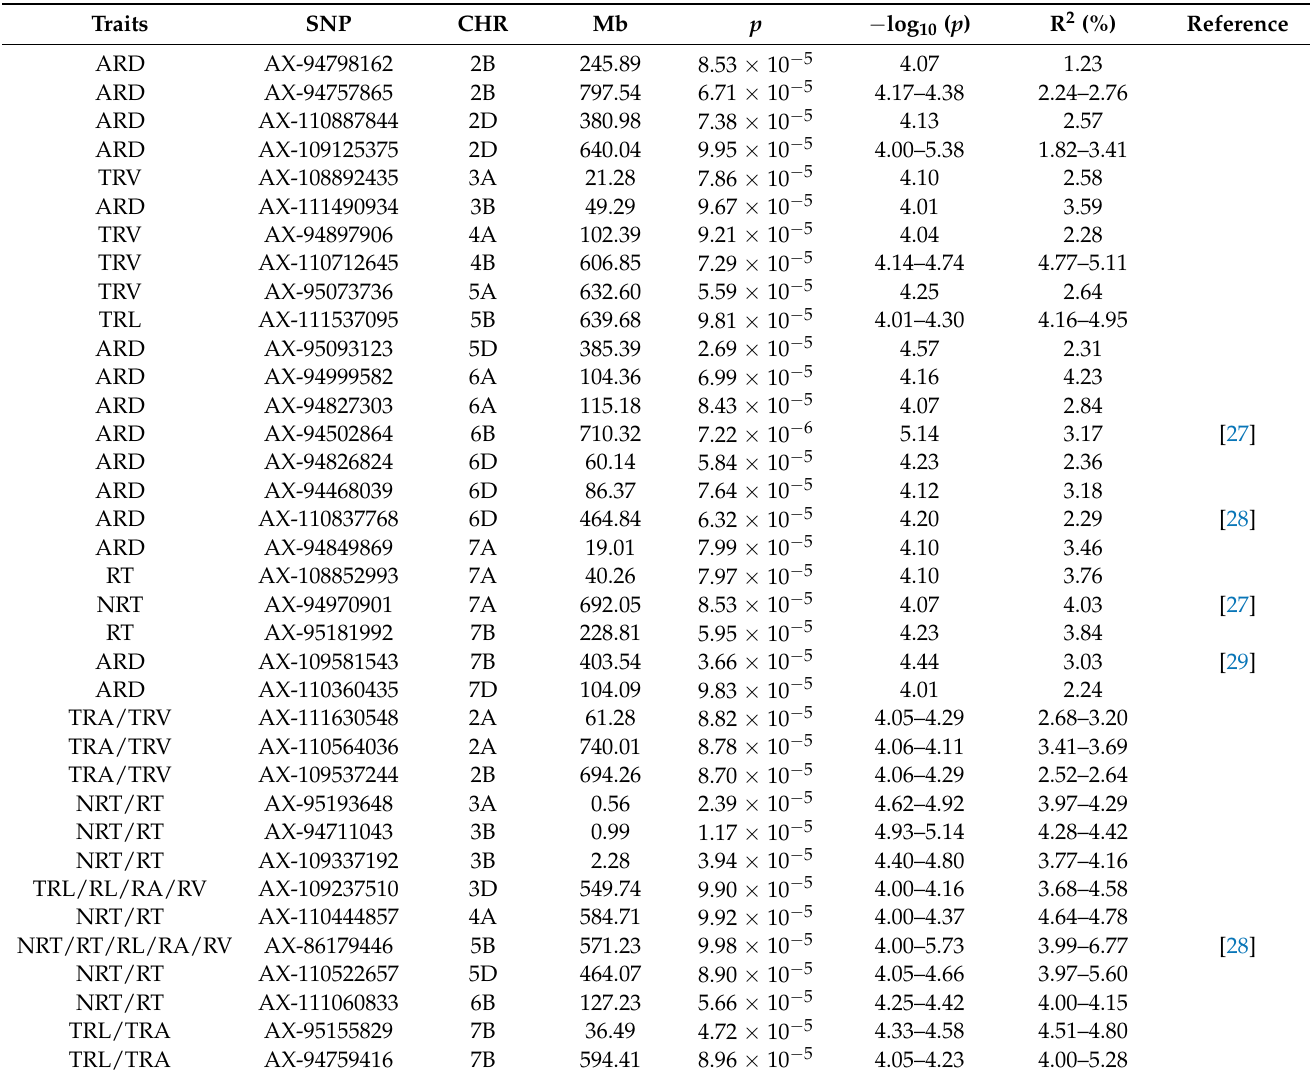
Table 4. QTLs and QTL clusters with RSA traits and overlapping with QTLs from previous